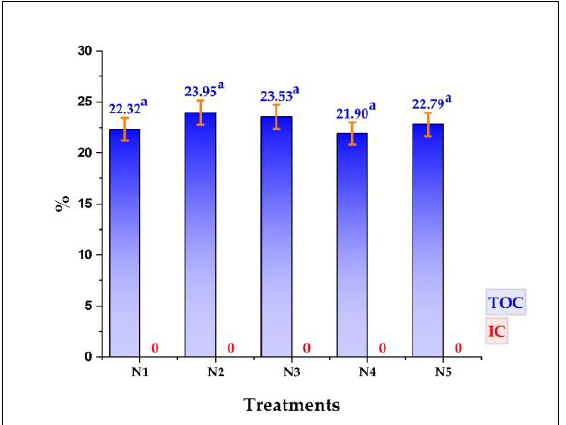
Figure 4. Total organic carbon (TOC) and inorganic carbon (IC) in N1, N2, N3, N4, and N5 nanoen- capsulates, equal letters indicate that there are no significant differences, evaluated with the Tukey test at 5% significance.